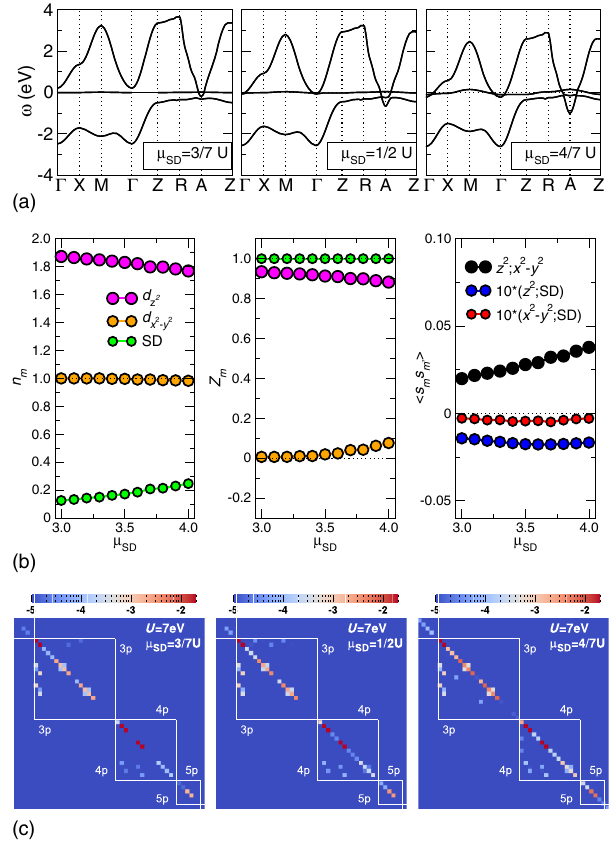
FIG. 9. Effect of μ on the electronic states for U ¼ 7 eV. SD (a) QP dispersion. (b) Orbital-resolved occupations, QP weights, and local spin-spin correlations. (c) Slave-boson weight matrix j ϕ qq 0 j 2 in higher particle